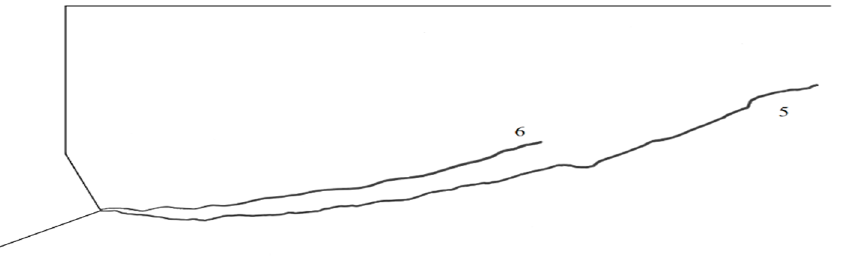
Figure 10. Comparison of destruction trajectories: elastic modulus—E I = 14,276 MPa, Poisson’s ratio ν 3 = 0.2. Trajectory No. 5—coefficient of friction μ 1 = 0.2, No. 6—coefficient of friction μ 2 = 0.4.